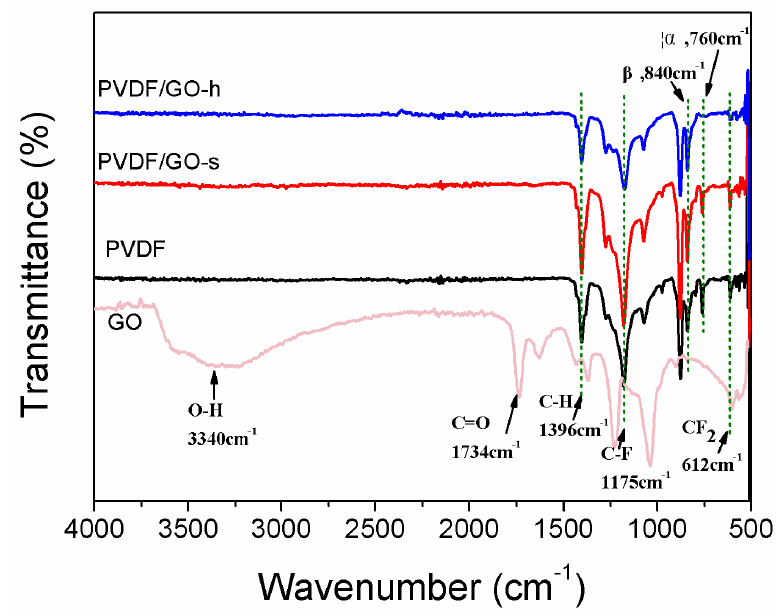
Figure 1. FTIR spectra of PVDF, PVDF/GO-s and PVDF/GO-h membranes.